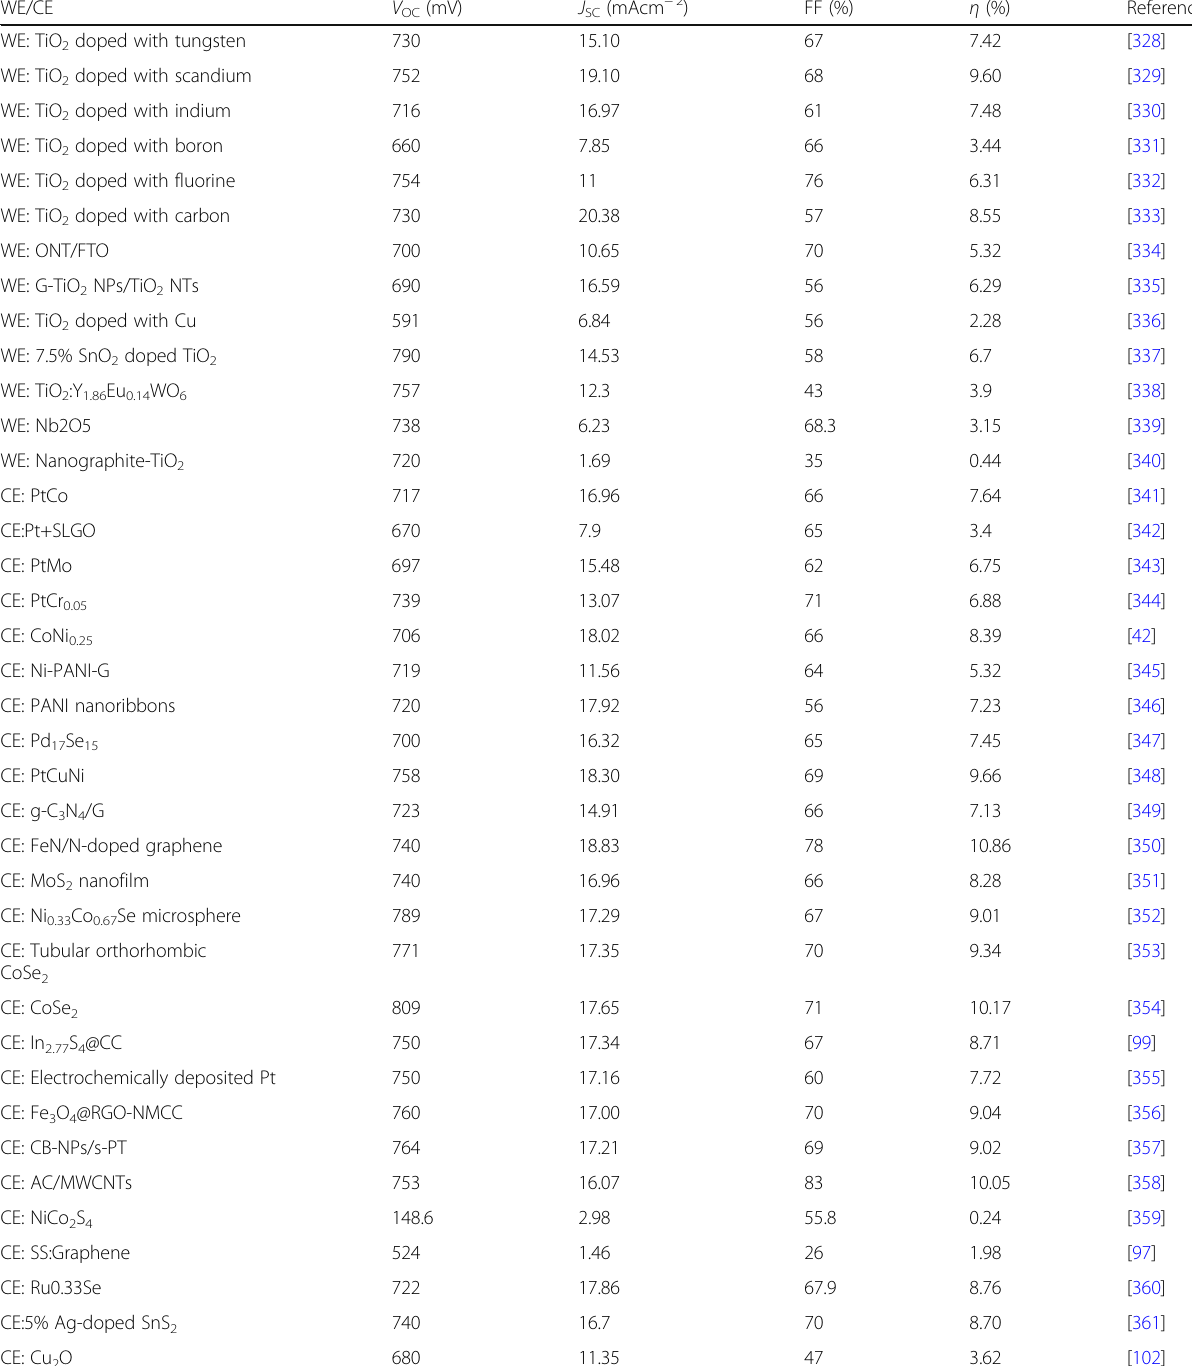
Table 1 Photovoltaic parameters of DSSCs employing different types of WEs and CEs WE/CE V OC (mV) J SC (mAcm − 2 ) FF (%) η (%)